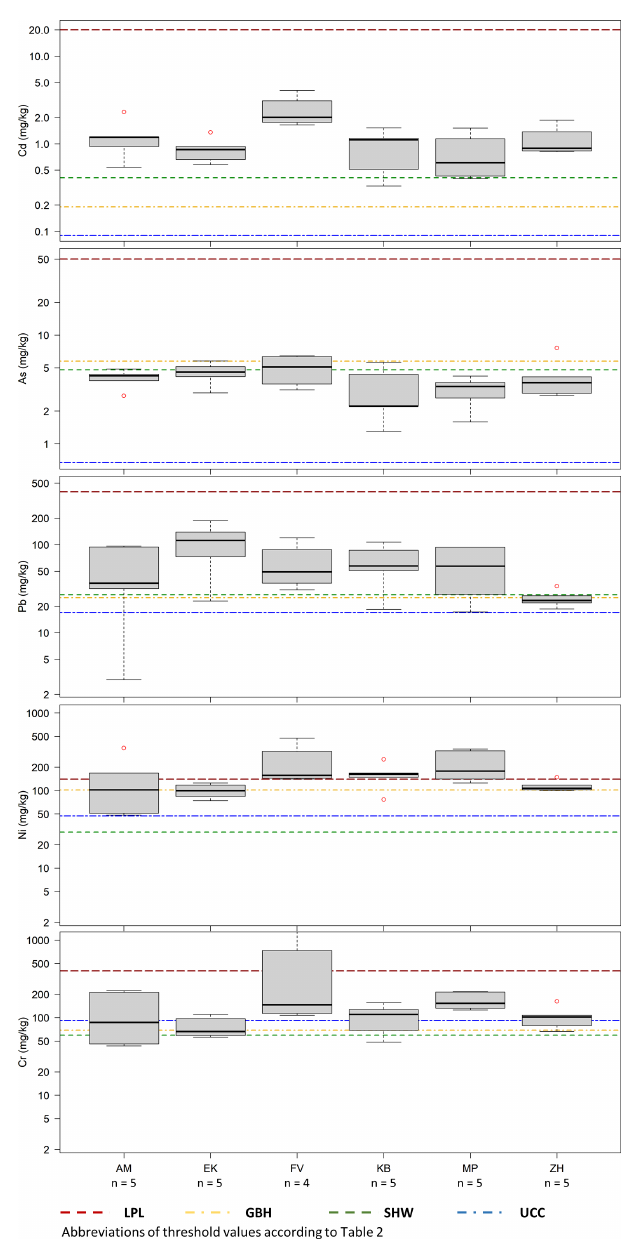
Figure 2. Concentrations of the heavy metals (given in mgkg − 1 ) Cd, Pb, Ni and Cr, with the metalloid As, according to sampling sites and different thresholds according Table